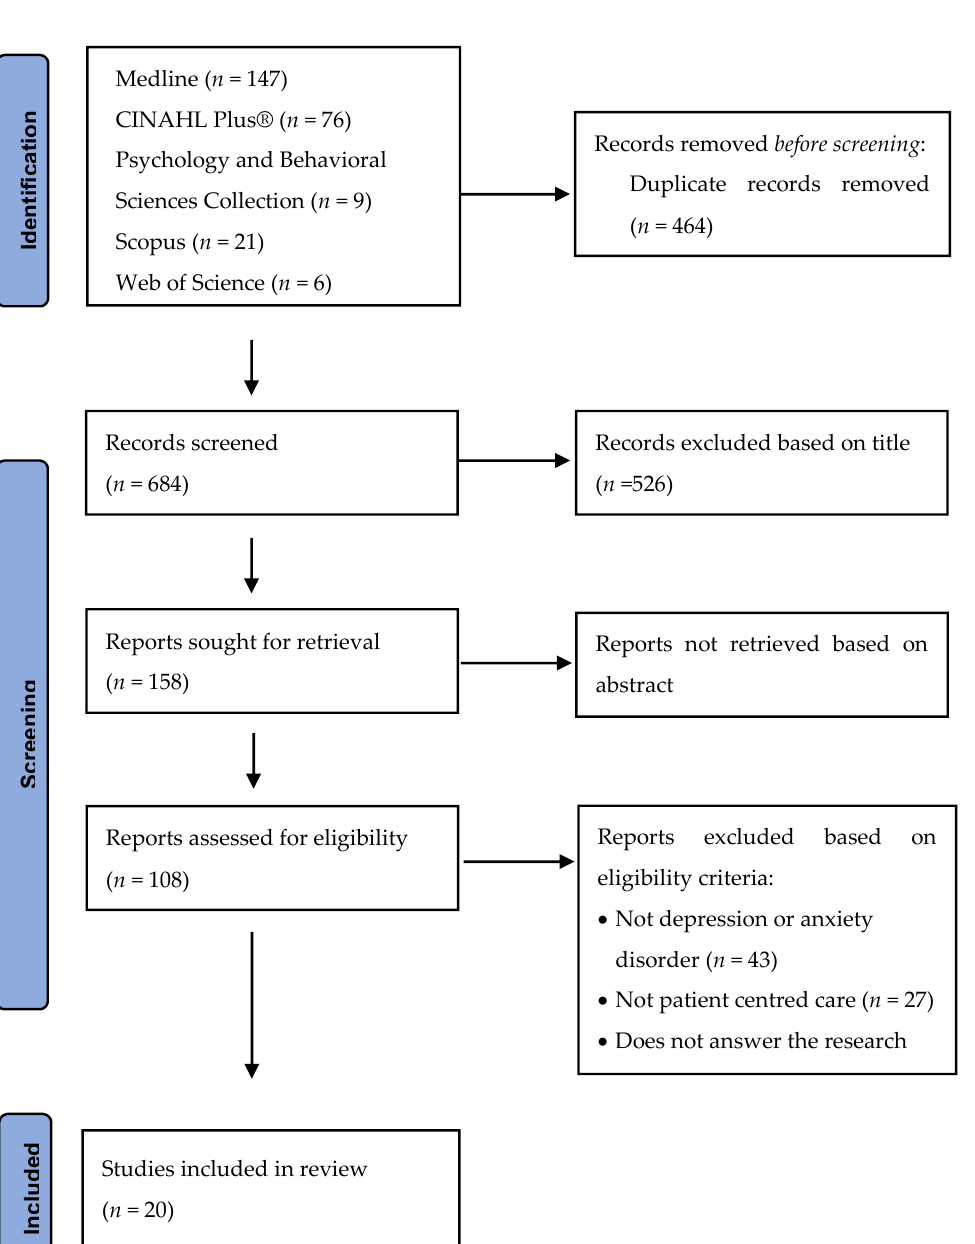
Figure 1. PRISMA